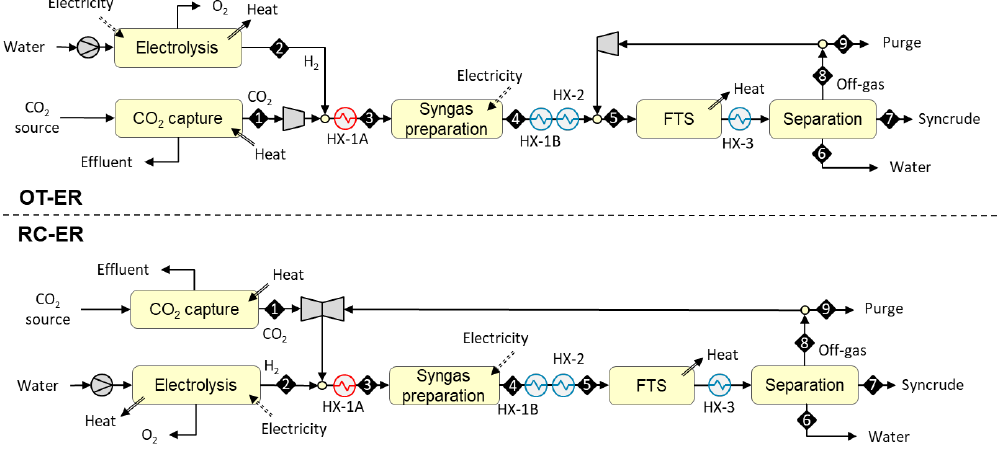
Figure 4. OT-ER and RC-ER configurations based on autothermal heating from electric resistance.